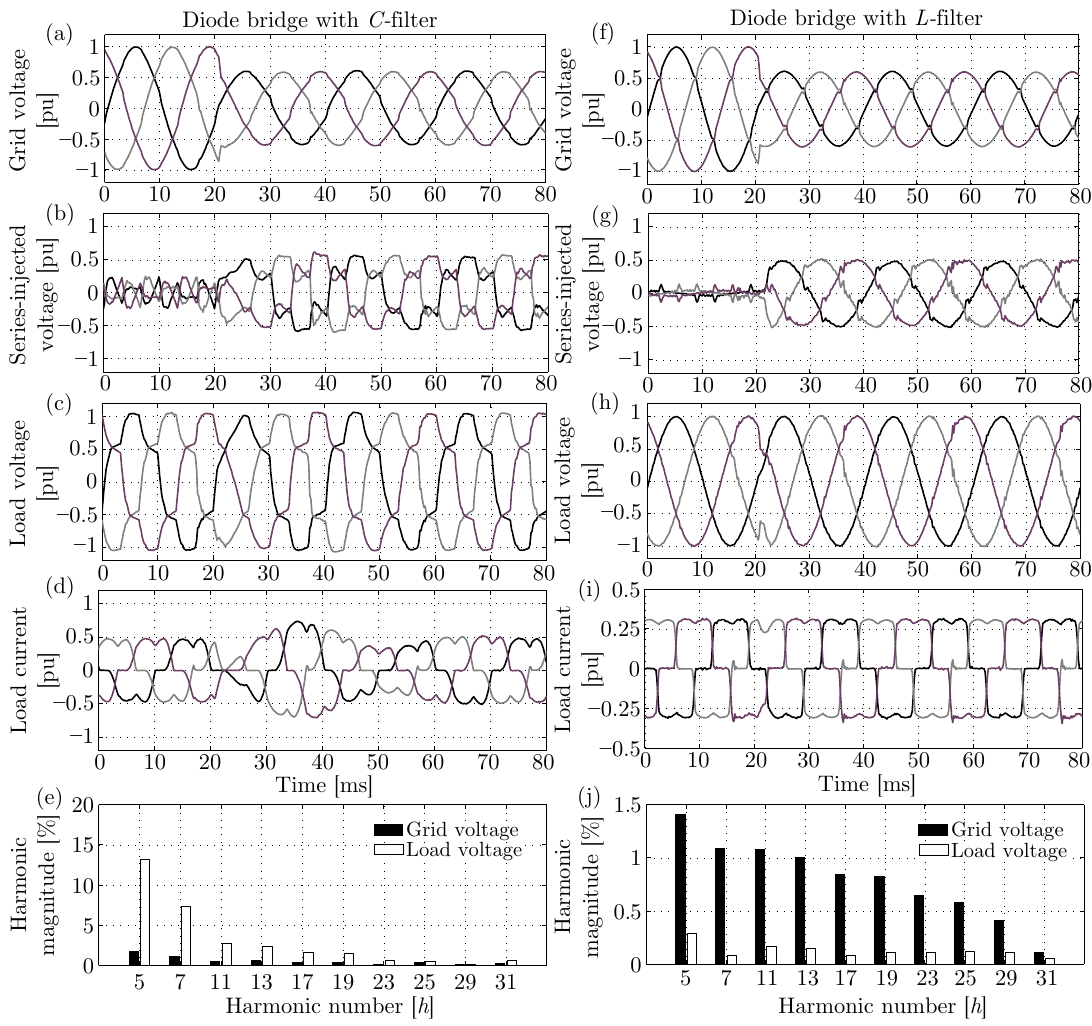
Figure 17. Experimental results. Mitigation of a 60% retained voltage sag when the load is a diode bridge with ( a – e ) a C -filter and ( f – j ) an L -filter. ( a , f ) Grid voltage, ( b , g ) series-injected voltage, ( c , h ) load voltage, ( d – i ) load current, and ( e – j ) harmonic content of the (black) grid and (white) load